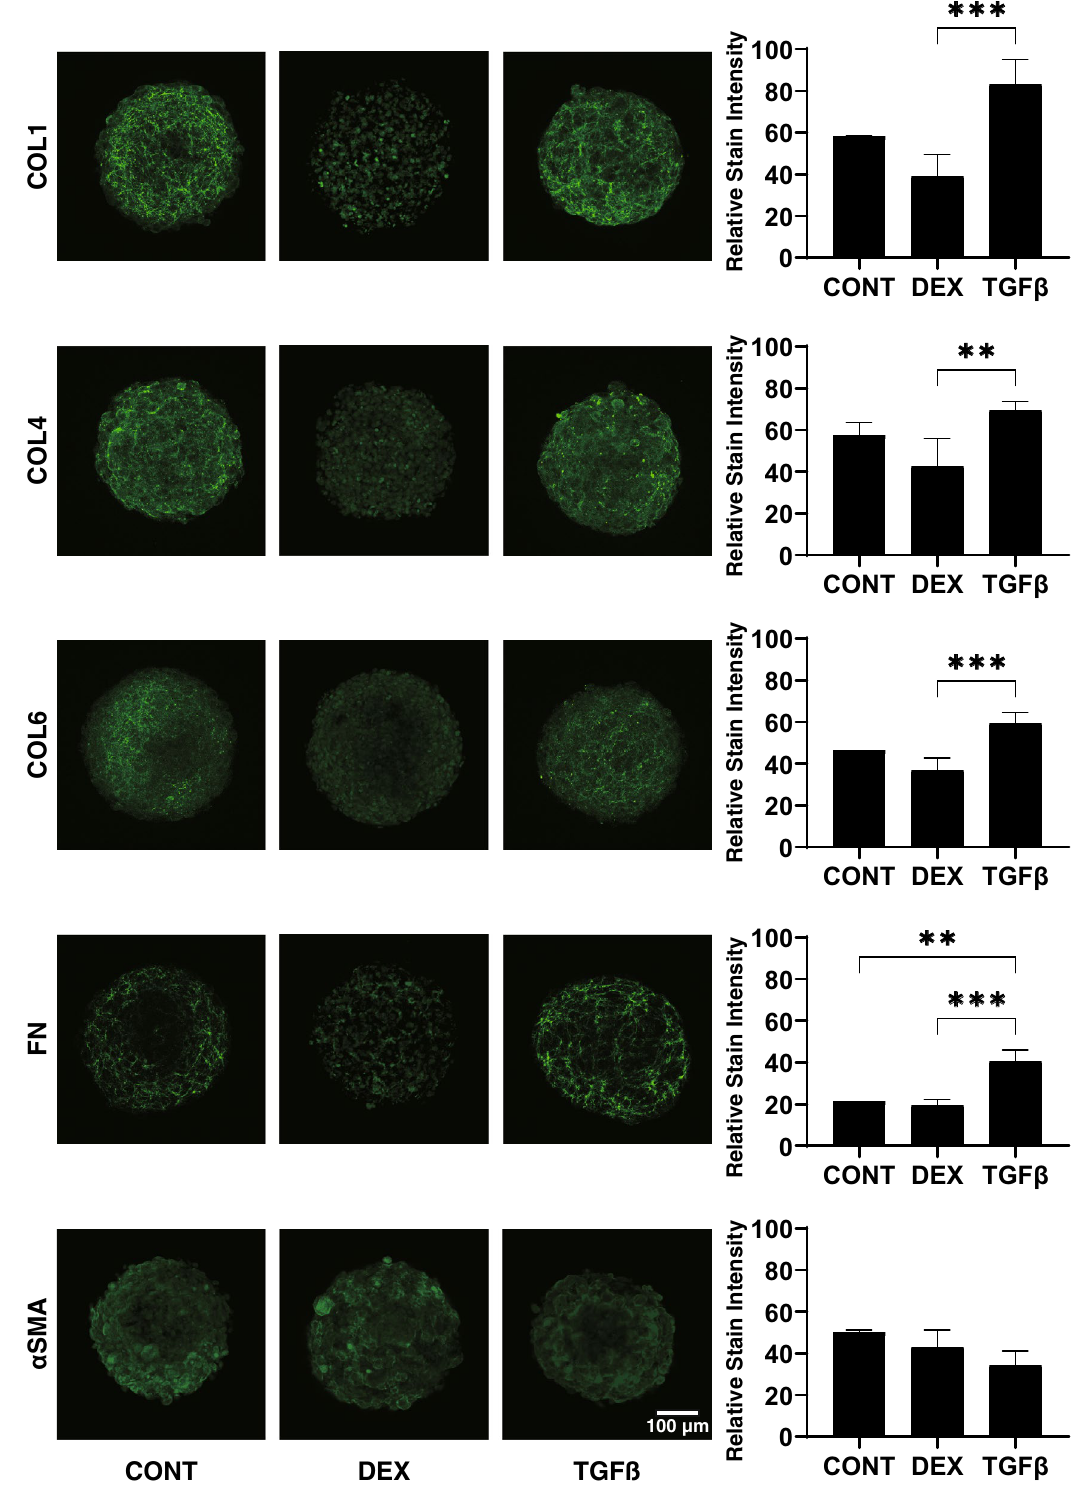
Figure 7. Immunolabeling of ECMs of the 3D HTM spheroids. Among the experimental groups treated with or without 250 nM DEX or 5 ng/ml TGFβ2, 3D HTM spheroids at Day 6 were subjected to immunostaining for COL 1 , COL 4 , COL 6 , FN and a-SMA . All experiments were performed in duplicate using fresh preparations (n = 4). Representative XY axes plane images are shown in left panels and relative staining intensities were plotted in right panels. Data are presented as the arithmetic mean ± standard error of the mean (SEM). ** P < 0.01; *** P < 0.005 (ANOVA followed by a Tukey’s multiple comparison test). Scale bar: 100